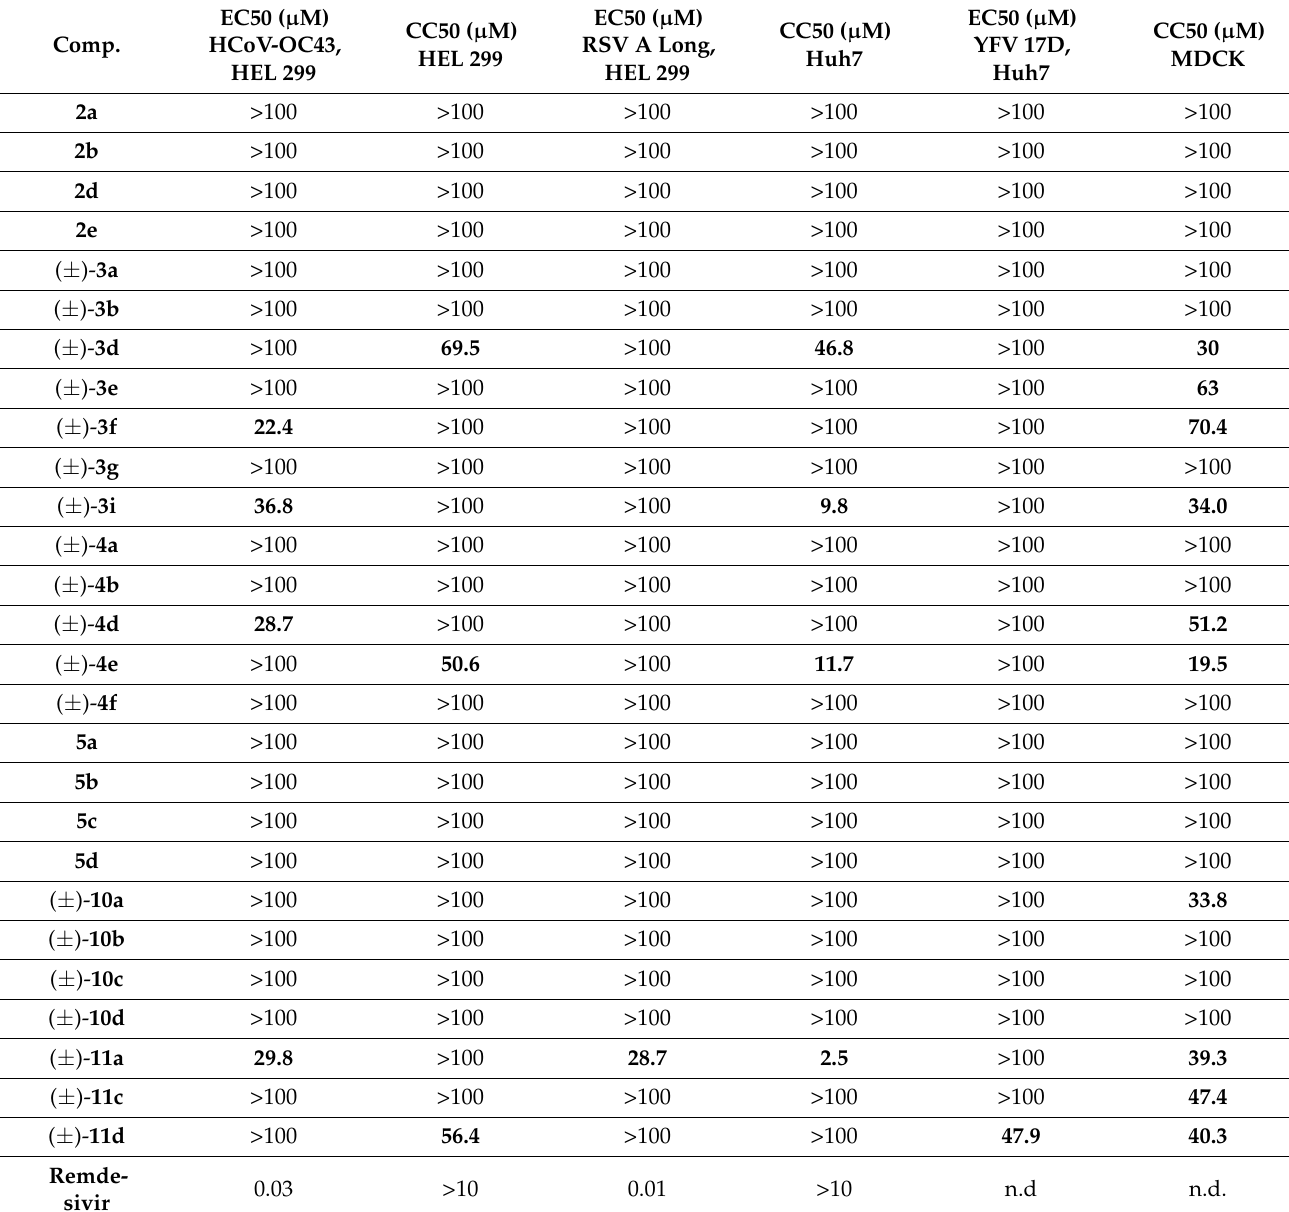
Table 1. Antiviral activity and cytotoxicity of compounds in cell